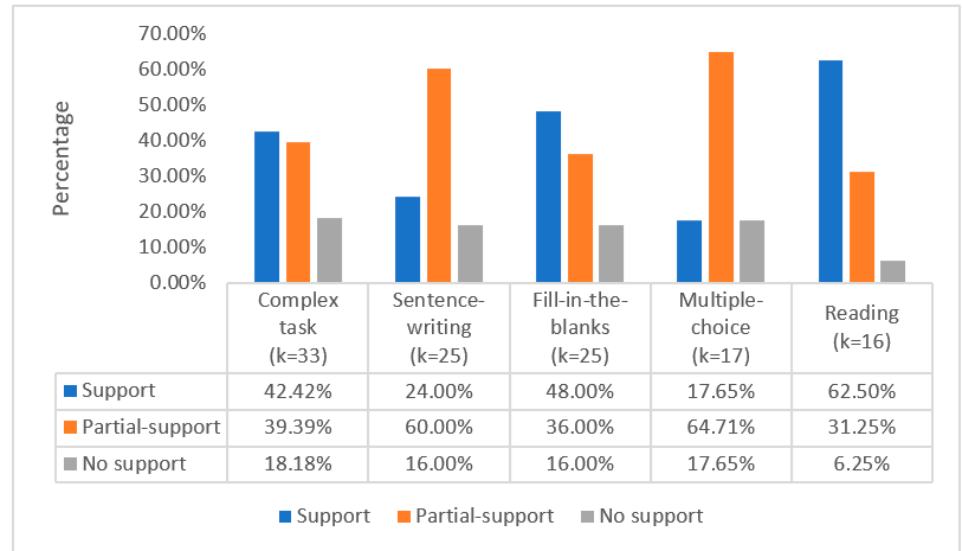
Figure 10. High-frequency task types and ILH support in studies.